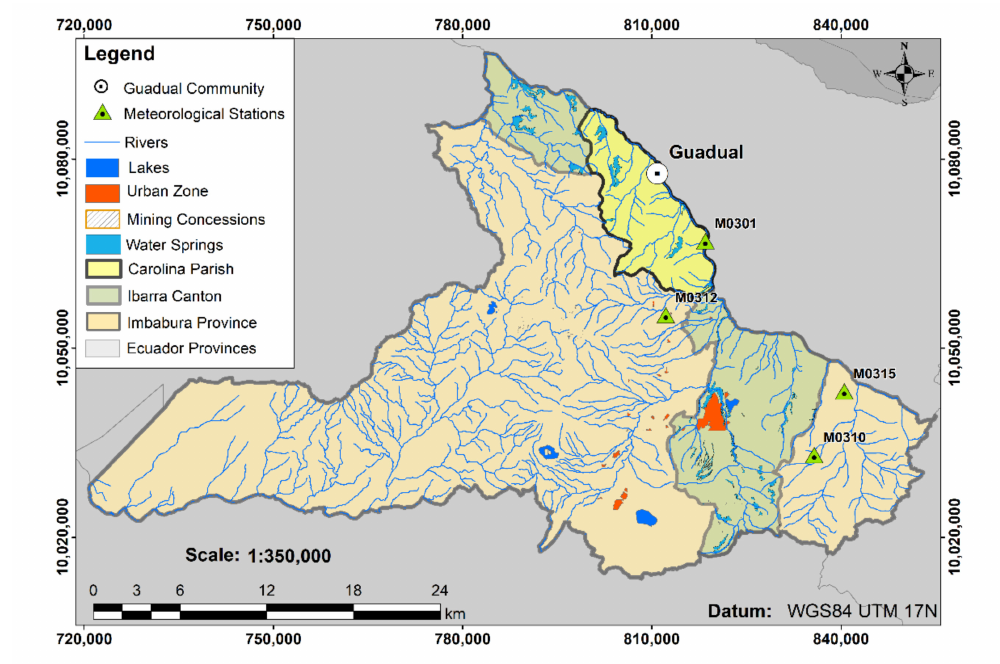
Figure 3. Meteorological stations location in the surroundings of the Ibarra